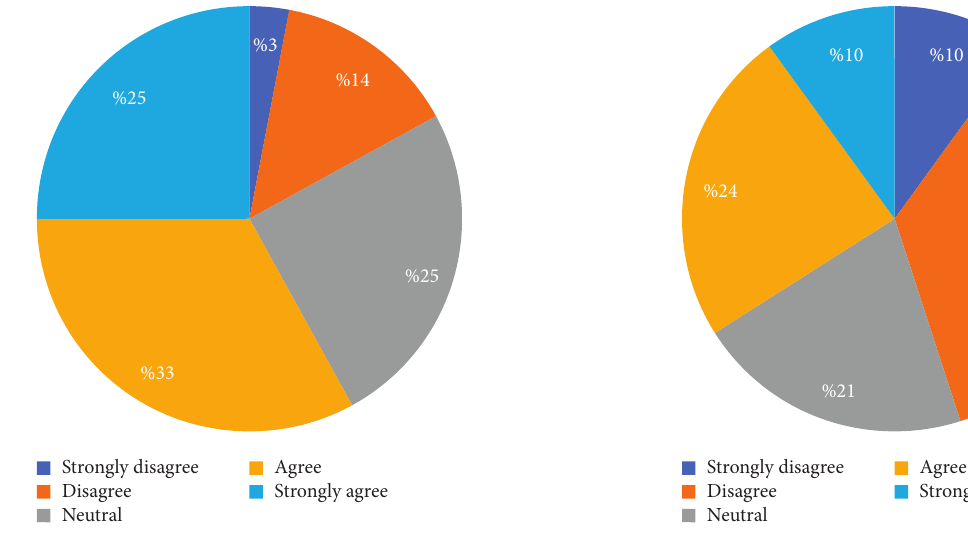
Figure 7: Q5: I think open data can be easily implemented in Kuwait.